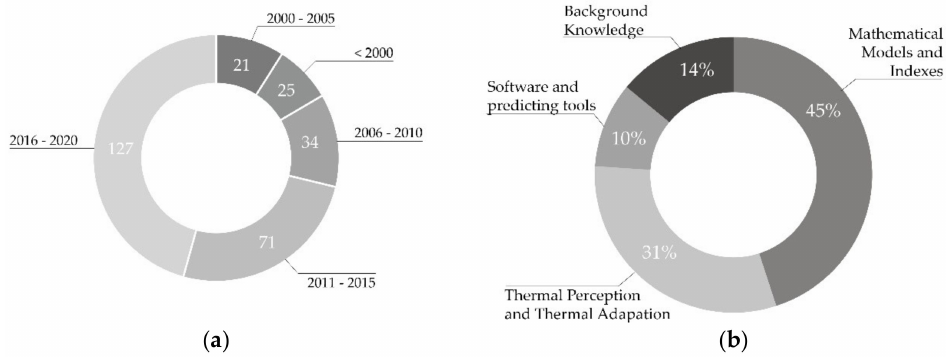
Figure 2. Distribution by year ( a ) and by topic ( b ) of the final 236 sources considered for the review